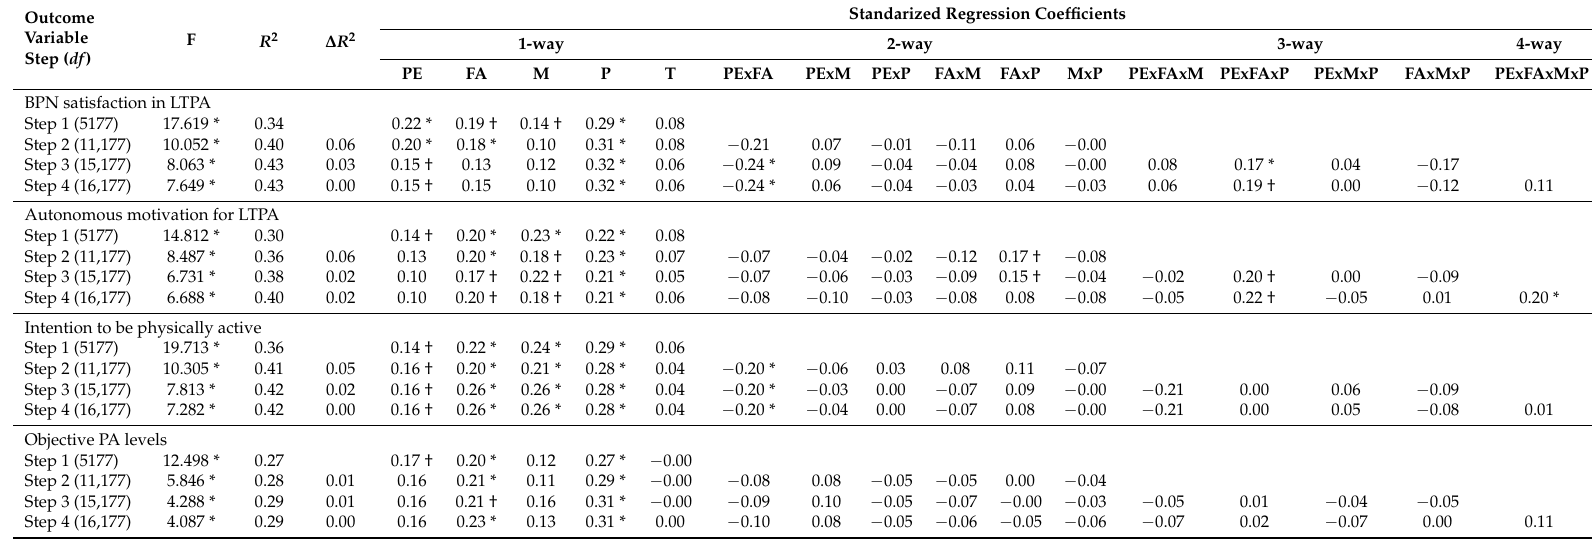
Table 2. Multivariate hierarchical regression analysis with autonomy support for PA from the PE teacher, father, mother, peers, and tutors, predicting need satisfaction and autonomous motivation for LTPA, intention to be physically active, and objective PA